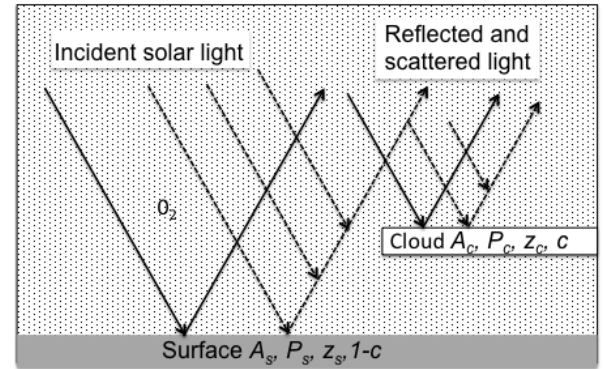
Figure 1. The atmospheric radiation model used in the FRESCO retrieval algorithm. Three light paths are considered: (1) from sun to surface to satellite, (2) from sun to cloud to satellite (1–2: solid lines) and (3) from sun to atmosphere to satellite according to single Rayleigh scattering (dashed lines). The pixel is partly cloudy, with c the effective cloud fraction, and partly clear. A s , P s and z s stand, respectively, for the surface albedo, pressure and altitude, while A c , P c and z c indicate, respectively, the cloud albedo, pressure and alti-